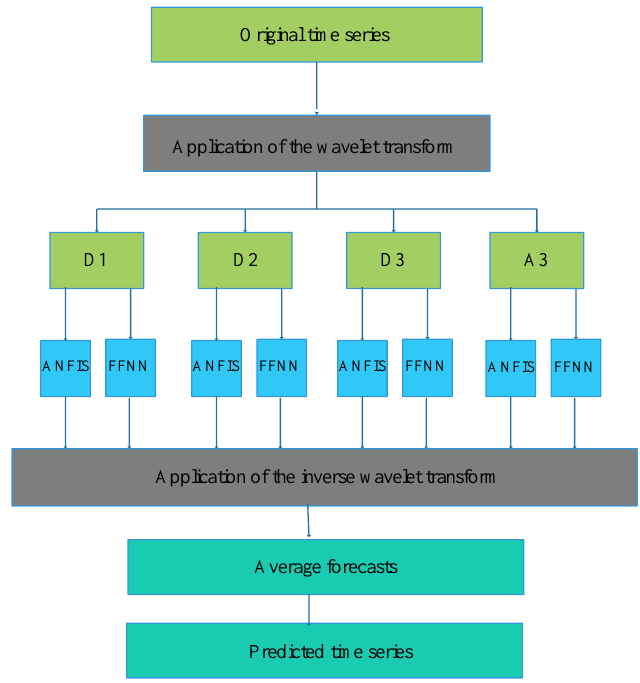
Figure 4. Structure of the proposed forecasting model using the wavelet components.